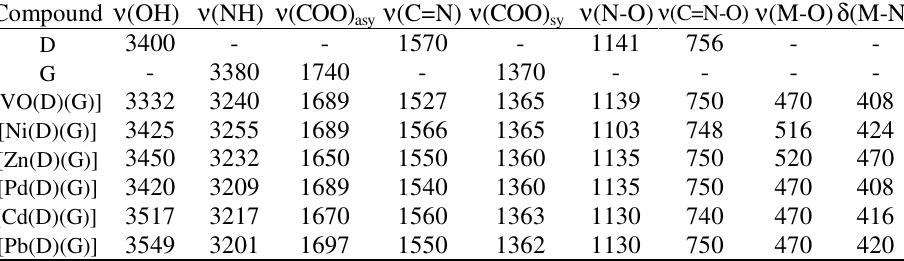
Table 2. The infrared spectral data (cm -1 ) of the free ligands and their